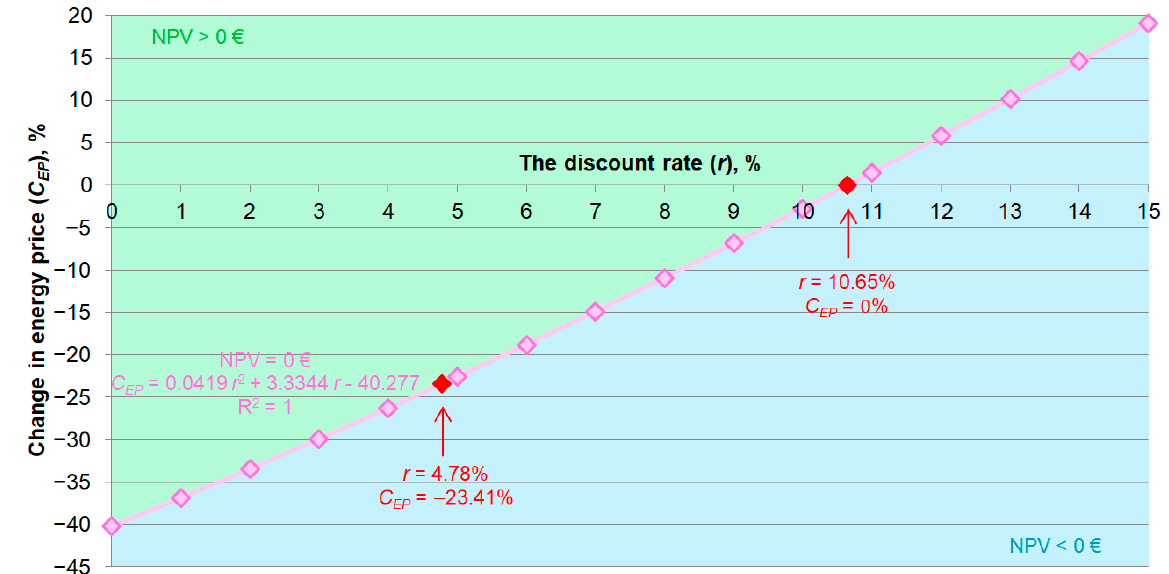
Figure 14. The results of the two-factor sensitivity analysis on the percentage changes in energy prices and the discount rate.